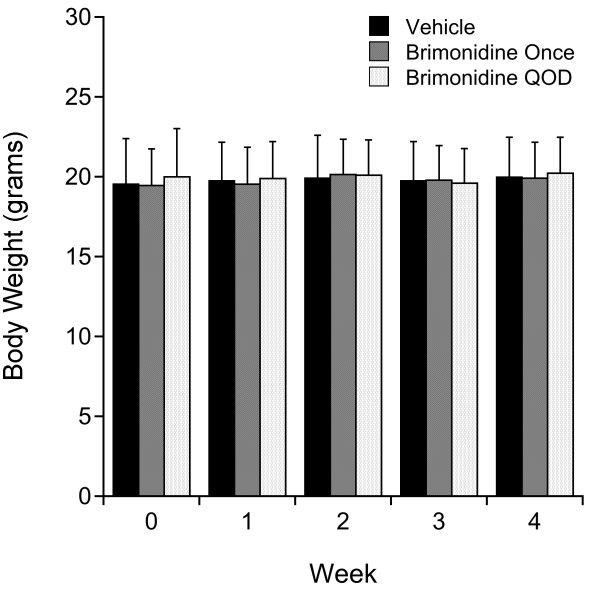
Absence of body weight change during the course of the study or difference among the treatment groups (P > 0.93 for each time point, ANOVA).